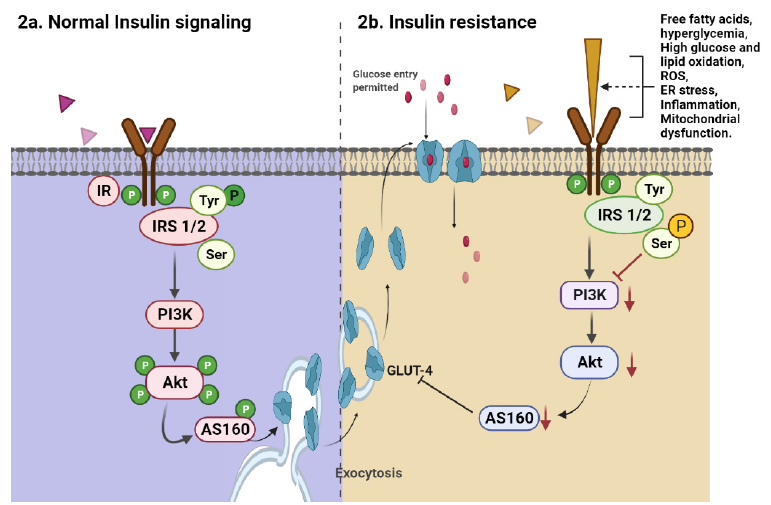
Figure 2. Molecular mechanism of action of insulin signalling under physiology and pathophysiological condition. Normal insulin signalling begins with insulin binding to the insulin receptor, then phosphorylation of the Tyr residue of IRS 1/2, and finally, activation of the PI3K and Akt enzymes ( a ). Activated Akt causes glucose translocation for oxidation by activating the GLUT4 transloaction proteins. In insulin resistance, instead of Tyr phosphorlation, serine residue phosphorlation after insulin binding to the insulin receptor leads to decreased activation of PI3K and Akt, resulting in decreased GLUTt4 translocation and glucose uptake. The red arrow indiactes IRS1/2 serine phosphorylation-mediated inhibition PI3K/Akt/AS160-mediated signalling that leads to insulin resistance due to various factors ( b ).